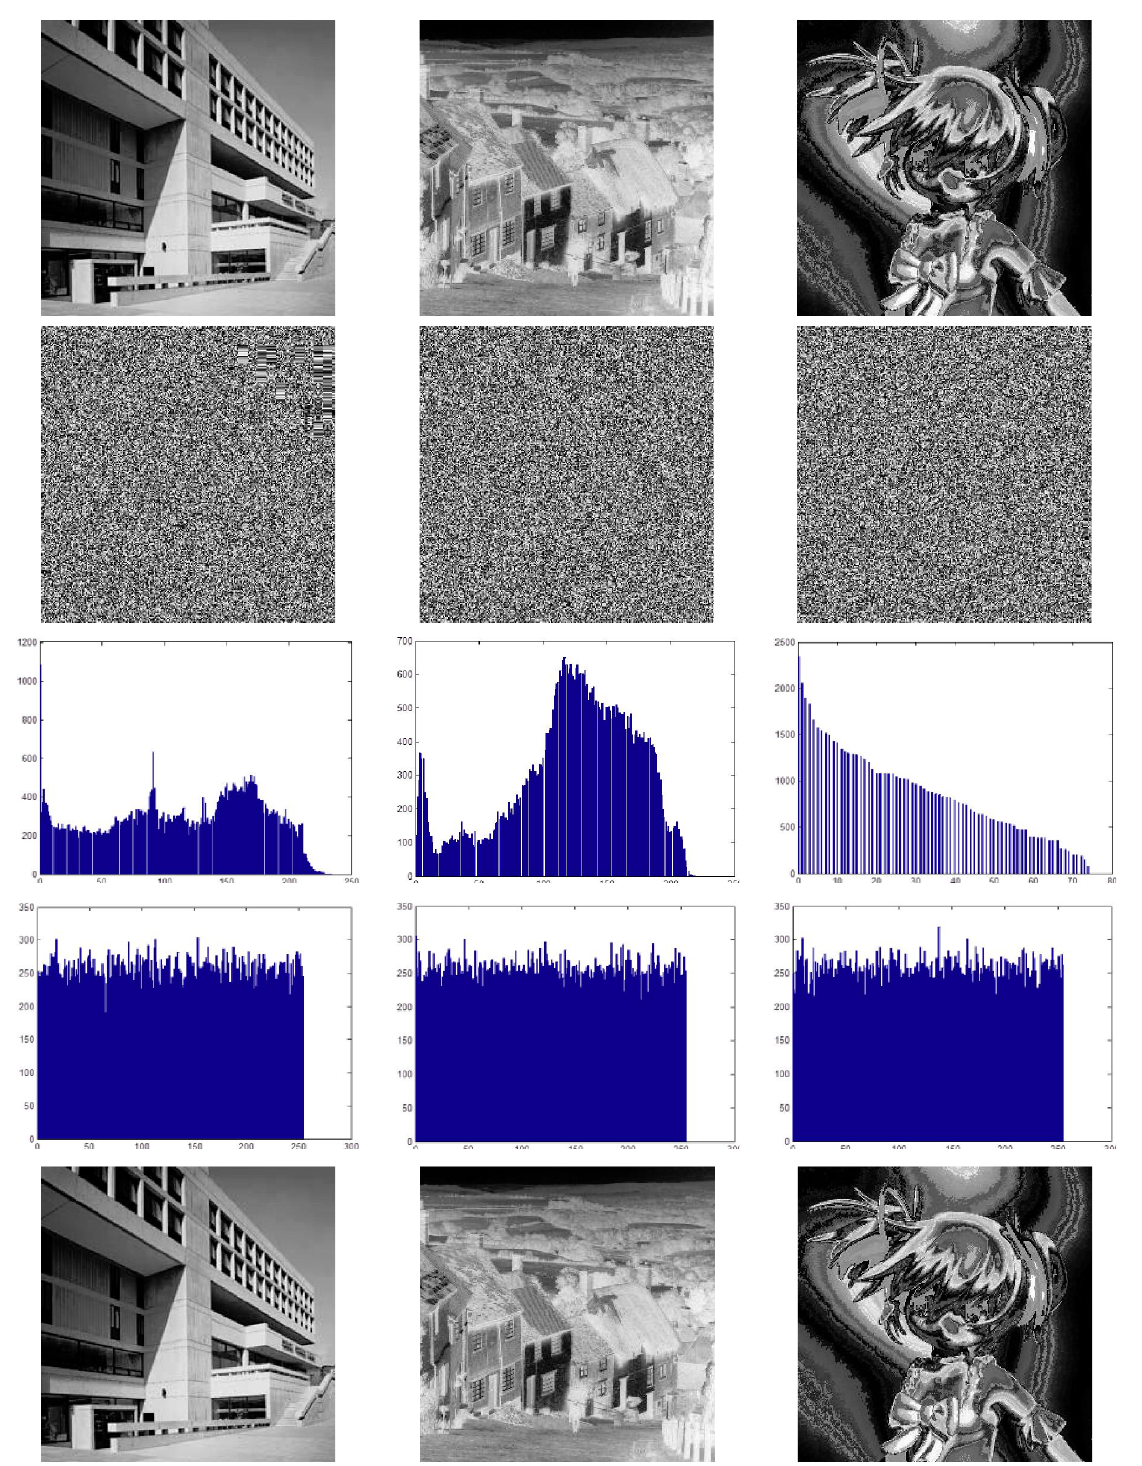
FIG. 3. ROW-1: ORIGINAL IMAGES: (I) CAMERAMAN (II) HOUSE-1 (III) PEPPER, ROW-2: ENCRYPTED IMAGES, ROW-3: HISTOGRAMS OF ORIGINAL IMAGES, ROW-4: HISTOGRAMS OF ENCRYPTED IMAGES, ROW-5: DECRYPTED